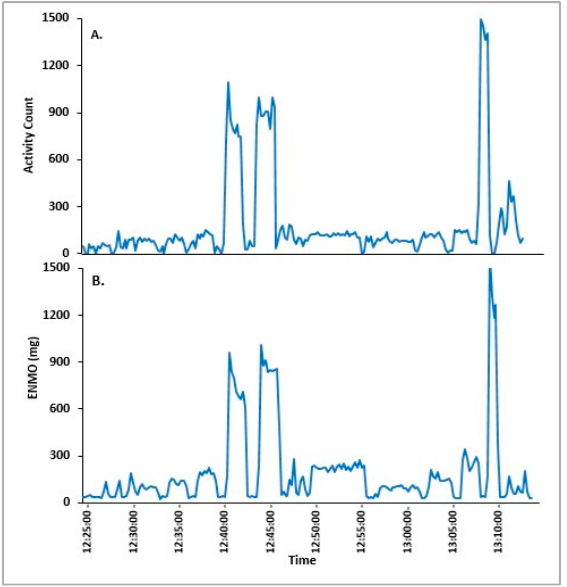
Figure 4. Representative epoch-by-epoch activity tracing of Actiwatch 2 (top) and Verisense (bot- tom) from a participant over a gym-based SP study.